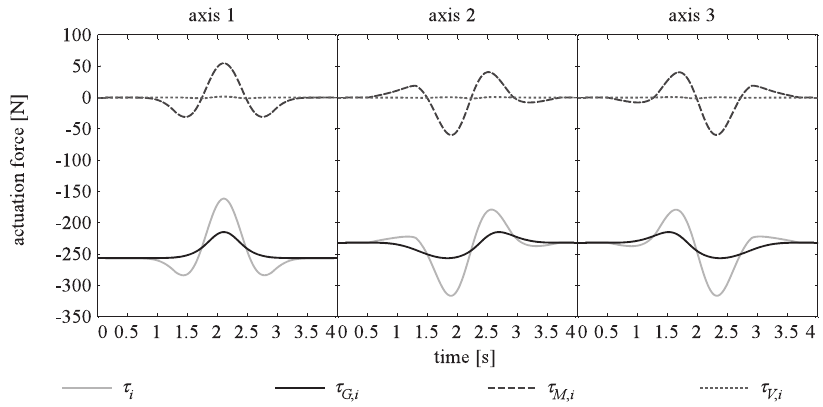
Figure 11. Di ff erent contributions to the total actuation e ff orts during a horizontal circular motion.